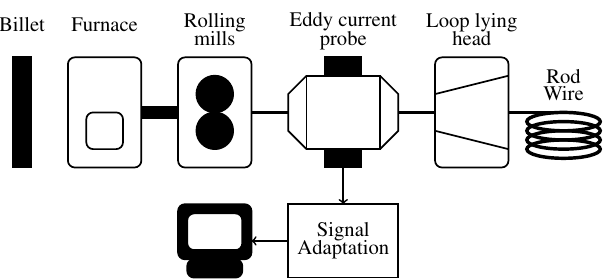
Figure 1. Layout of a wire rod mill with the eddy current inspection